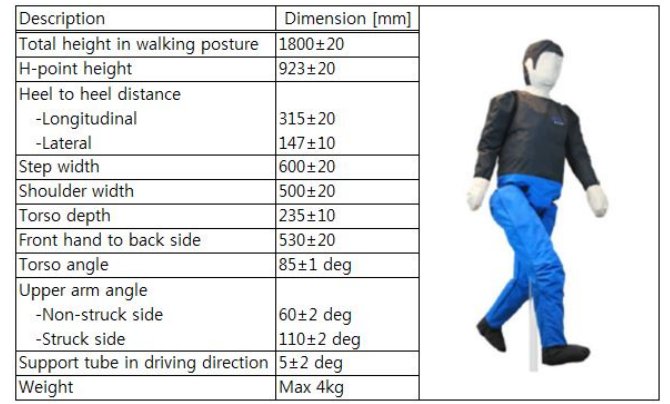
Figure 7. AEBS VRU-Pe scenario of Euro NCAP test method.